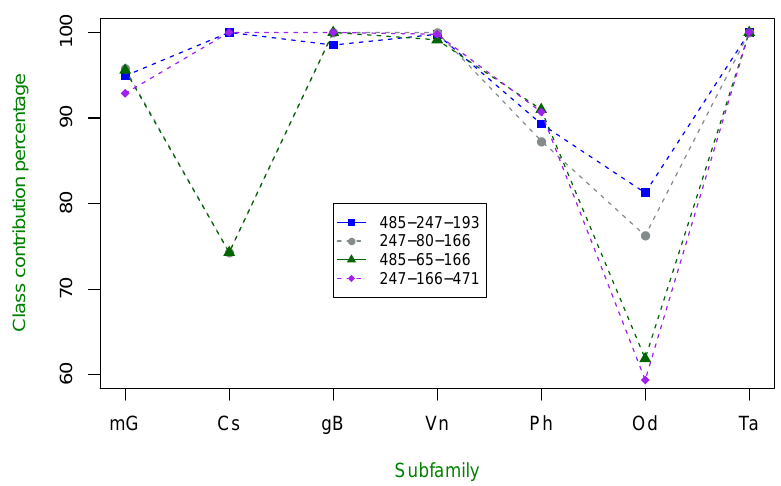
Figure 4. Class-specific percentage of contribution to overall classification using three amino acid property index combinations with the highest classification accuracy. As in Figures 2 and 3, the tendency of index combination 485-247-193 is similar, but the recognition rate of the Od subfamily is highly improved.